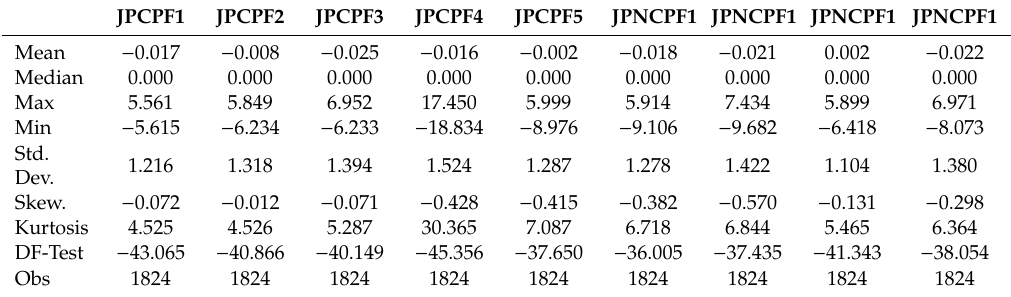
Table 1. Descriptive statistics of the excess returns of Japan equity funds under the Central Provident Fund (CPF) Investment Scheme and non-CPF Japan equity